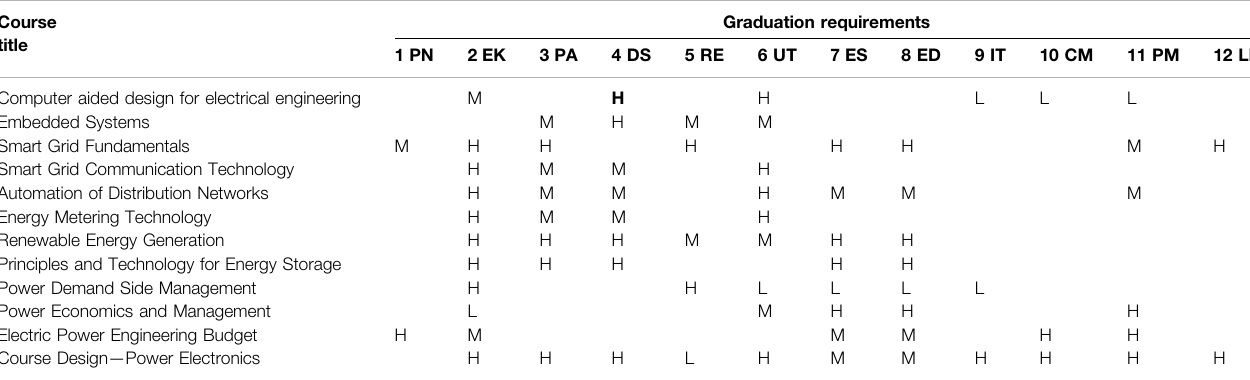
TABLE 7 | Correspondence matrix of the new opened